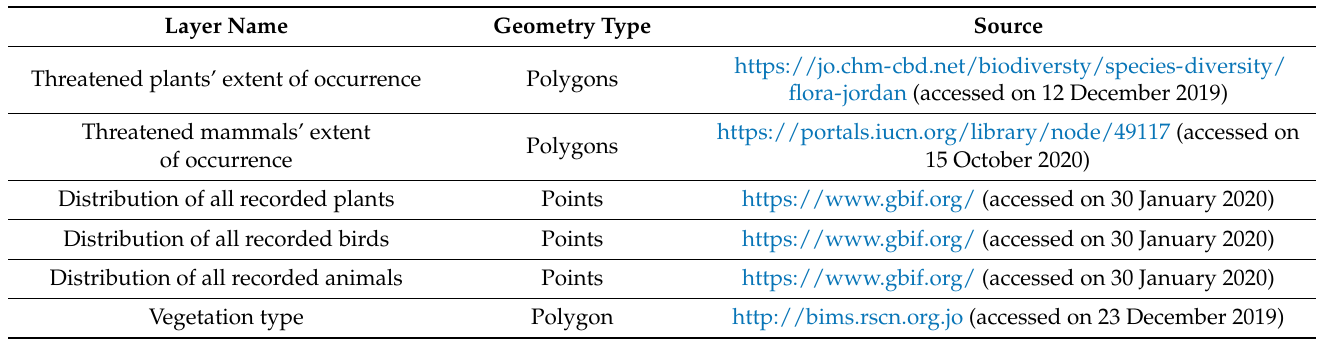
Table 3. The layers used to create the RBI in this study.